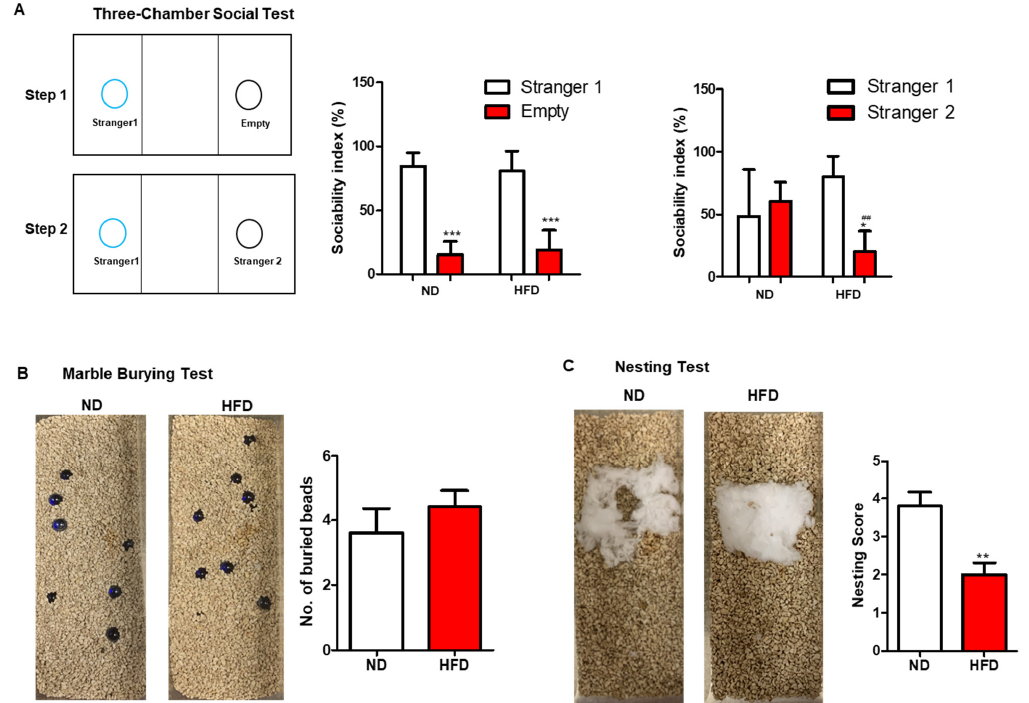
Figure 3. Effect of long-term HFD consumption on autism-like behavior in mice. Schematic diagram, sociability index between stranger 1 and empty cage, and sociability index between stranger 1 and stranger 2 of three-chamber social test ( A ). Representative images and number of burying beads in marble burying test ( B ). Representative images and nesting score in nesting test of ND- and HFD- fed mice ( C ). Values are shown as the mean ± SEM. T-test or two-way ANOVA with a post hoc Tukey test was performed. * p < 0.05; ** p < 0.01; *** p < 0.001 vs. ND, ## p < 0.01 vs. stranger 1.